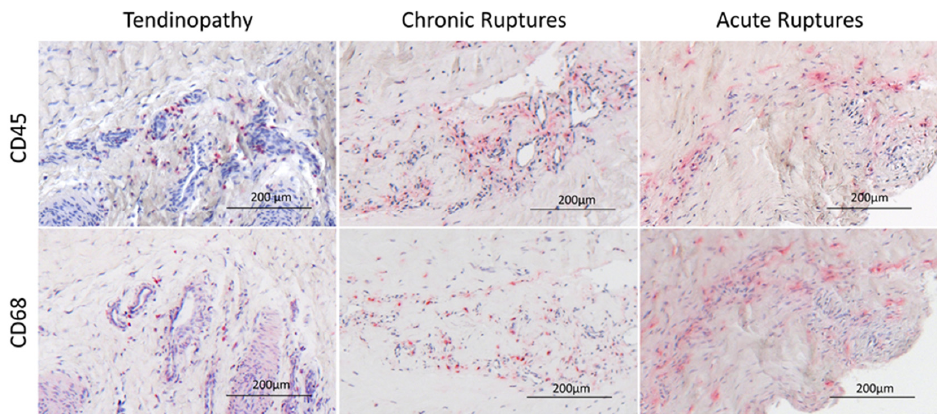
Figure 3. Exemplary images of inflammatory cell infiltration visualized by immunohistological CD45 (leucocytes) and CD68 (monocytes/macrophages) staining in tendinopathic tendons, chronic ruptures and acute ruptures.